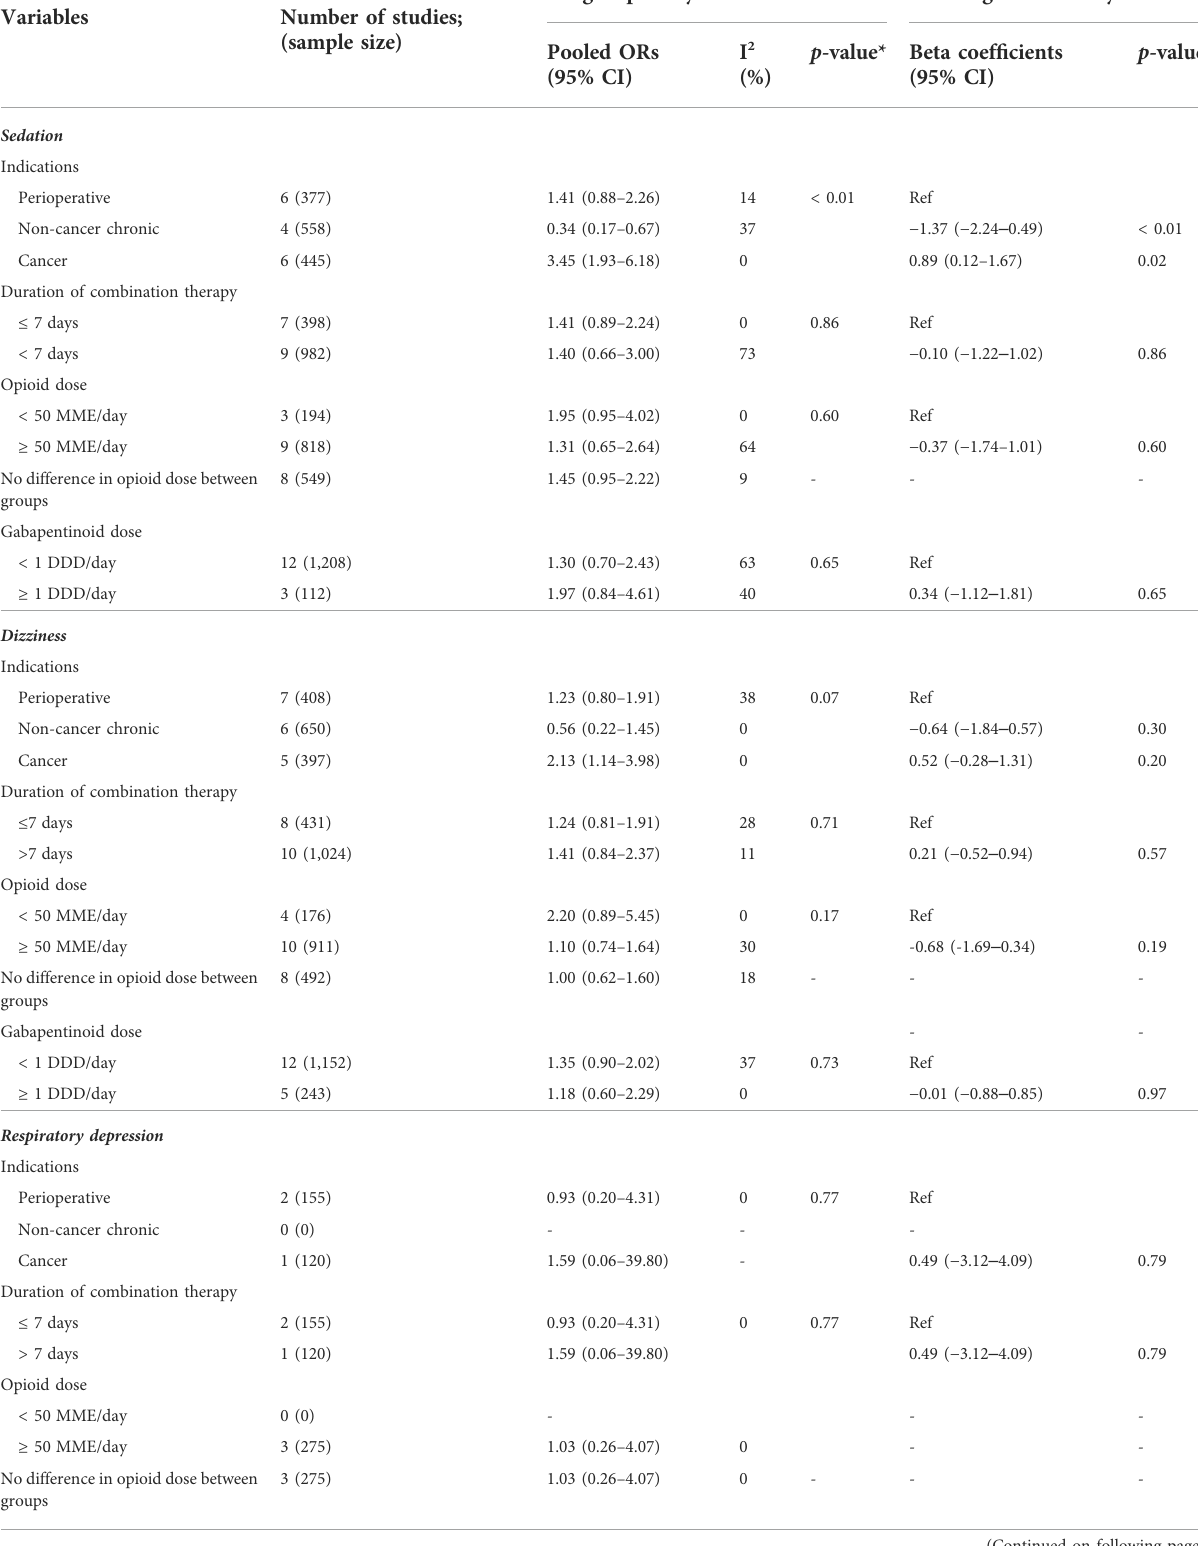
TABLE 3 Subgroup and meta-regression analyses of the risk of central nervous system depression and gastrointestinal disorders in randomized controlled